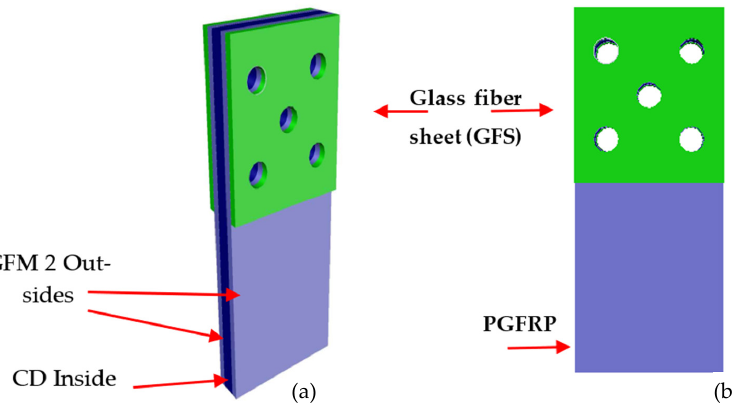
Figure 4. Strengthening diagram of GFSs for PGFRP connections: ( a ) perspective view of PGFRP with element section, ( b ) front view.